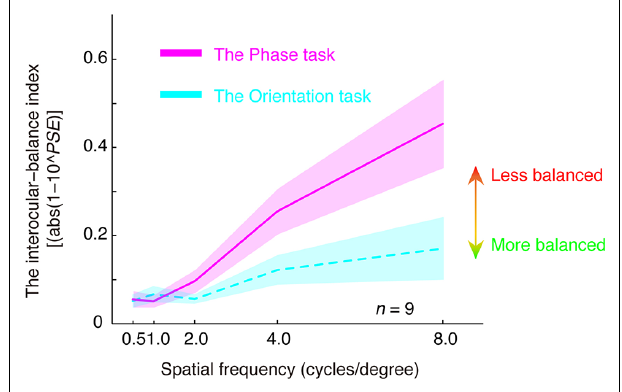
FIGURE 4 | The relationship between the interocular-balance index and spatial frequency. The interocular-balance index was calculated by abs(1–10 PSE ) and plotted as a function of the spatial frequency for the two tasks. Areas indicate the range of ± between subjects’